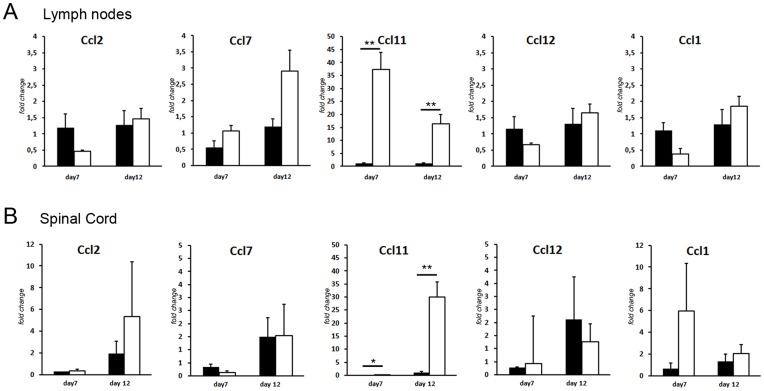

Eae18b congenic animals significantly upregulate Ccl11 mRNA.qPCR was used to measure mRNA expression of Ccl2, Ccl7, Ccl11, Ccl12 and Ccl1 in draining lymph nodes (A) and spinal cord tissue (B) on day 7 and 12 p.i. Ccl11 mRNA was significantly upregulated in the congenic strain in both lymph node and spinal cord tissue at both time-points. Five to eight animals per strain were used at each time-point and experiments were repeated three times. Error bars represent SEM, statistics were calculated using Mann-Whitney non-parametric test, (*) indicates p-value <0.05, (**) indicates p-value <0.01.